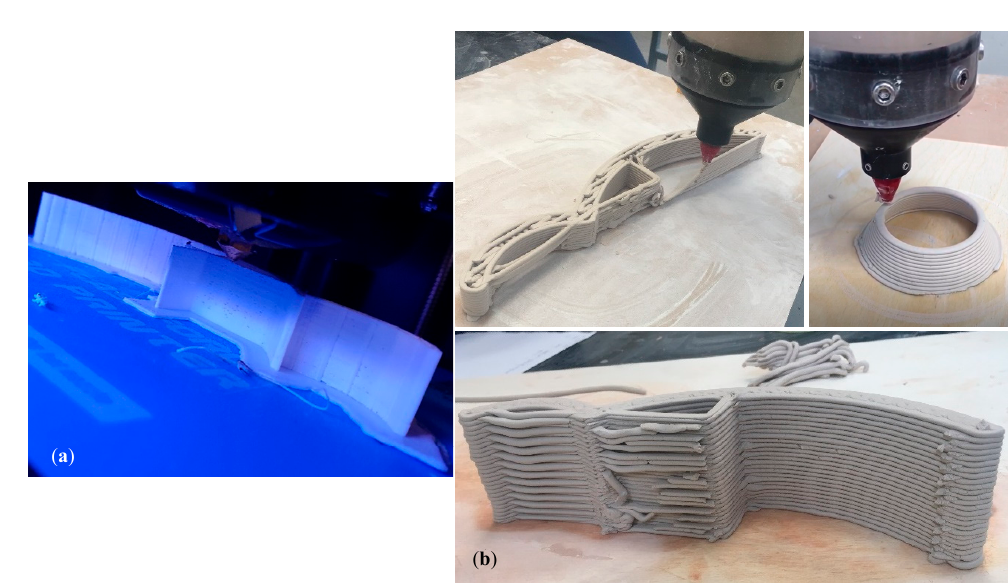
Figure 7. 3DP models created at the laboratory by the investigators: ( a ) using plastic materials; ( b ) using clay (source: authors).